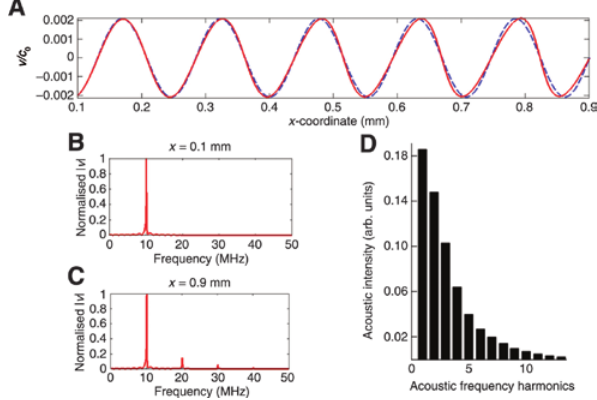
Figure 2: Giant nonlinear acoustic properties. (A) Deformation of the sound wave during its propagation in an acoustically nonlinear medium (here modelled with a finite-difference time-domain method [96] using the nonlinear acoustic coefficient of water β = 3.5). The blue dashed line denotes the same wave but propagating in an idealised ( β = 0) medium with the same remaining material parameters. (B, C) Fourier transformation of the acoustic wave performed at two different spatial coordinates. At x = 0.1 mm, the wave = 10 MHz. New acoustic harmonics is monochromatic with frequency f a appear in the spectrum as the wavefront is deformed. Reprinted from Giant nonlinear response of a cloud of gas bubbles in a liquid